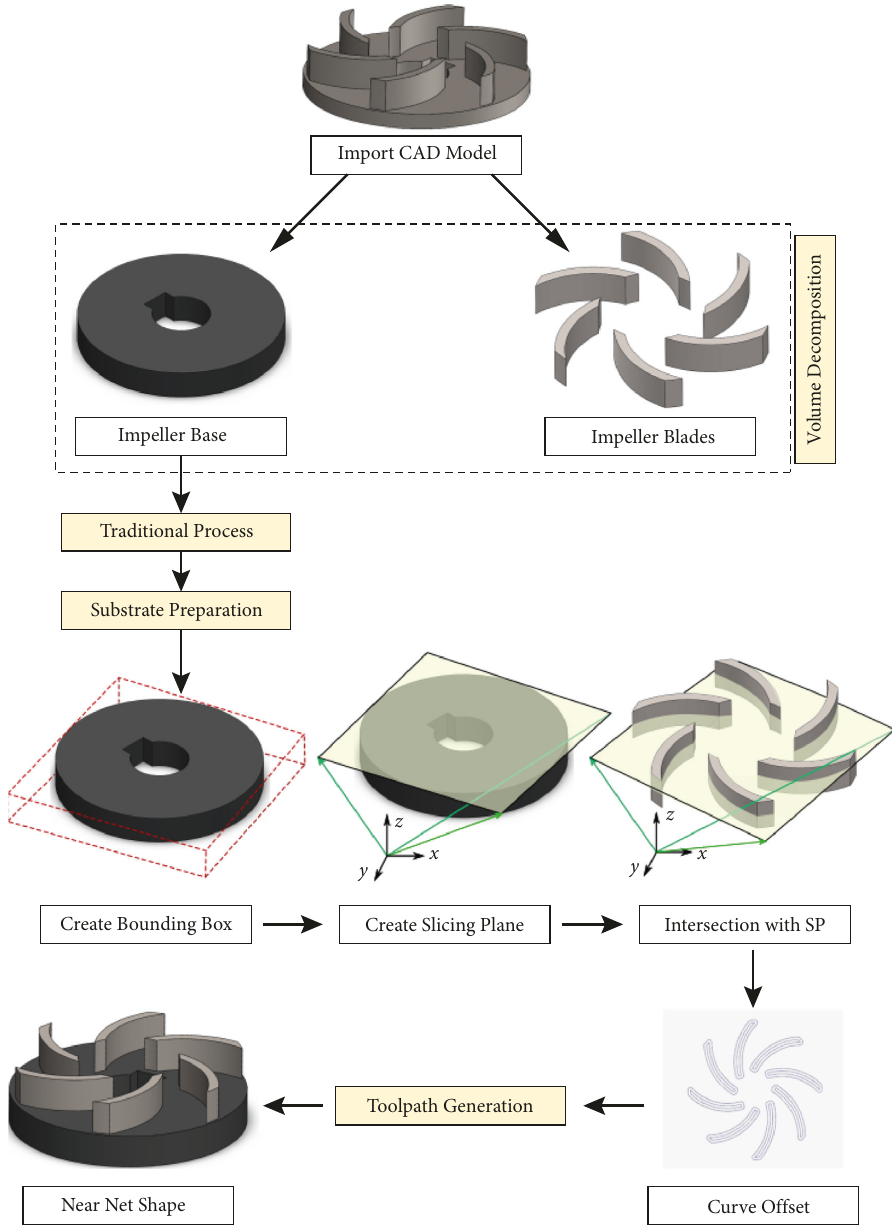
Figure 22: Process flow for embedded substrate method.